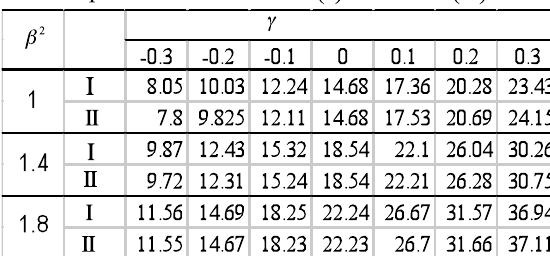
Table 7. Comparison of results for buckling load factor